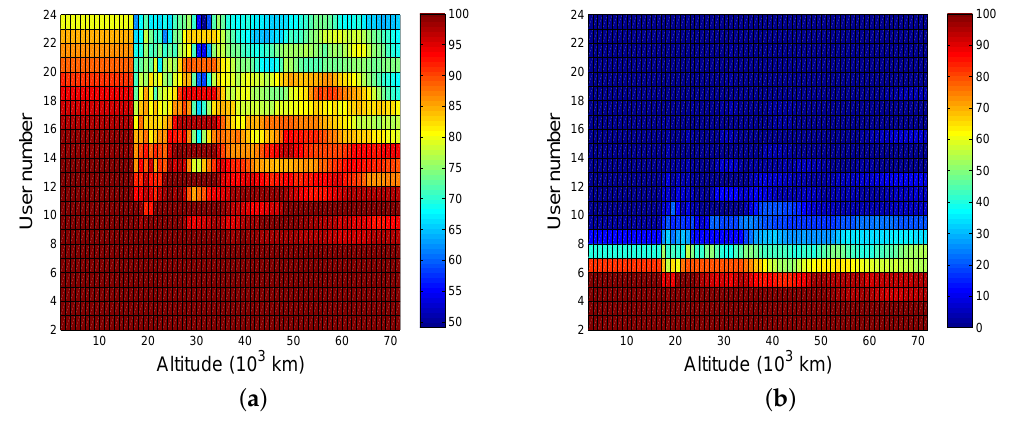
Figure 10. The available probability of ASMT (the worst user): ( a ) one or more; ( b ) four or